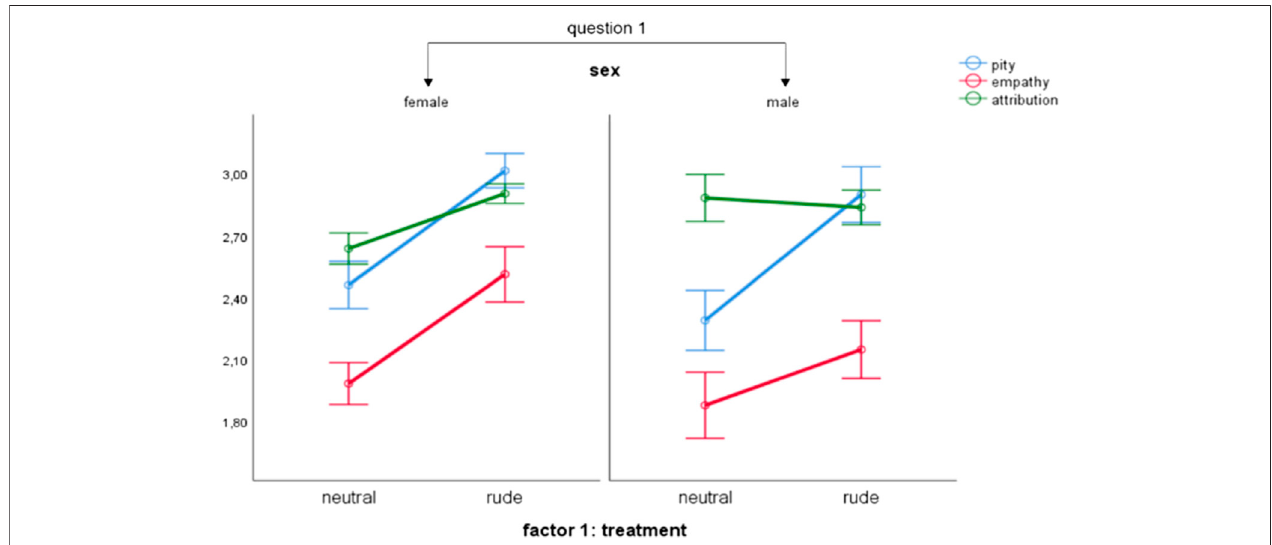
FIGURE 5 | Effects of treatment and participant ’ s gender on empathy with the CA (controlled for trait empathy).